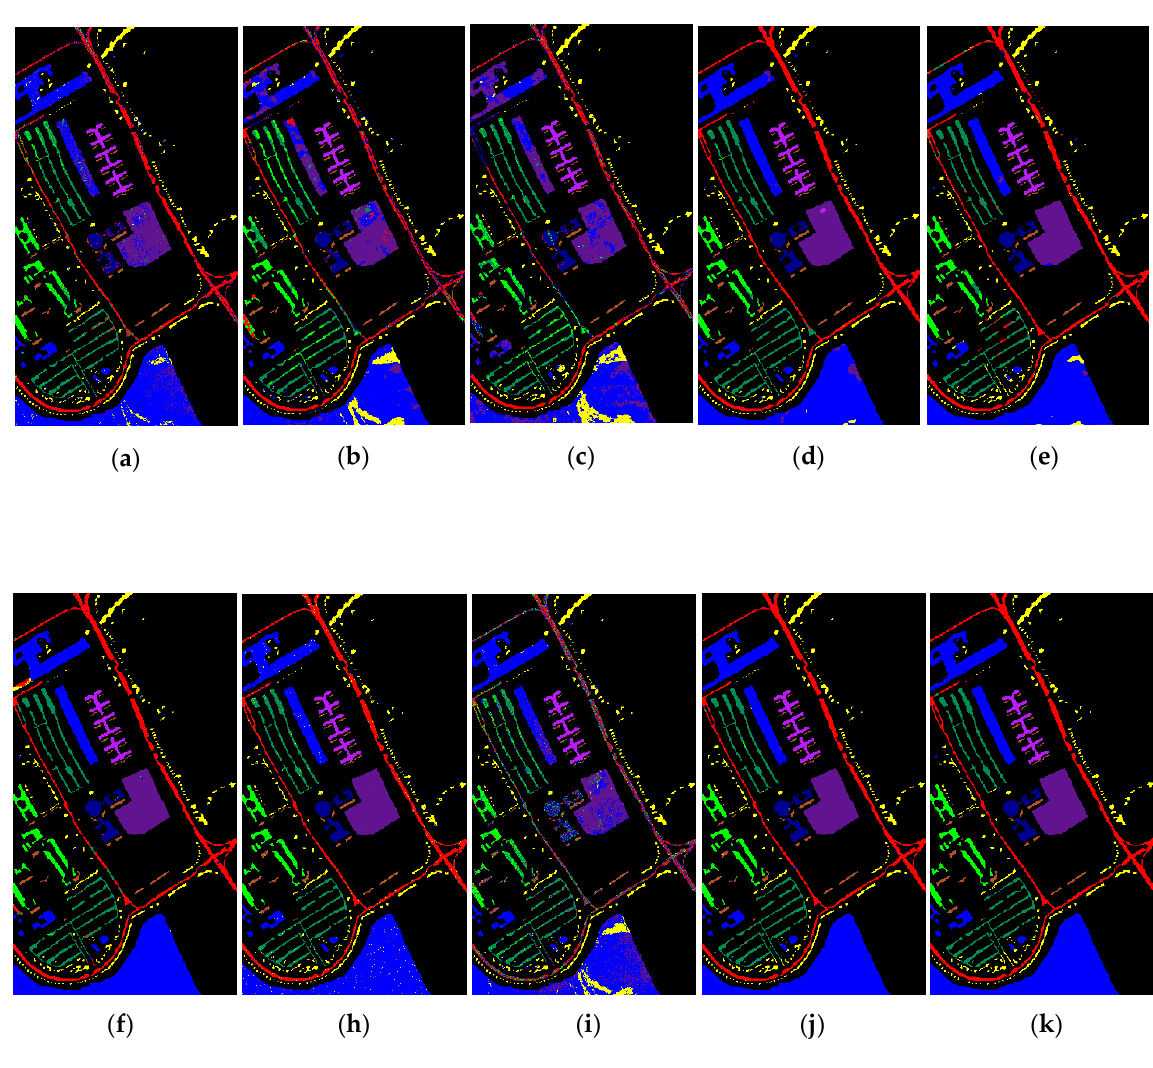
Figure 11. Classification maps of the Salinas dataset. ( a ) SVM 91.89%; ( b ) HiFi-We 91.10%; ( c ) SSG 81.46%; ( d ) EPF 95.92%; ( e ) GSVM 96.93%; ( f ) IFRF 98.86%; ( h ) LPP_LBP_BLS 99.83%; ( i ) BLS